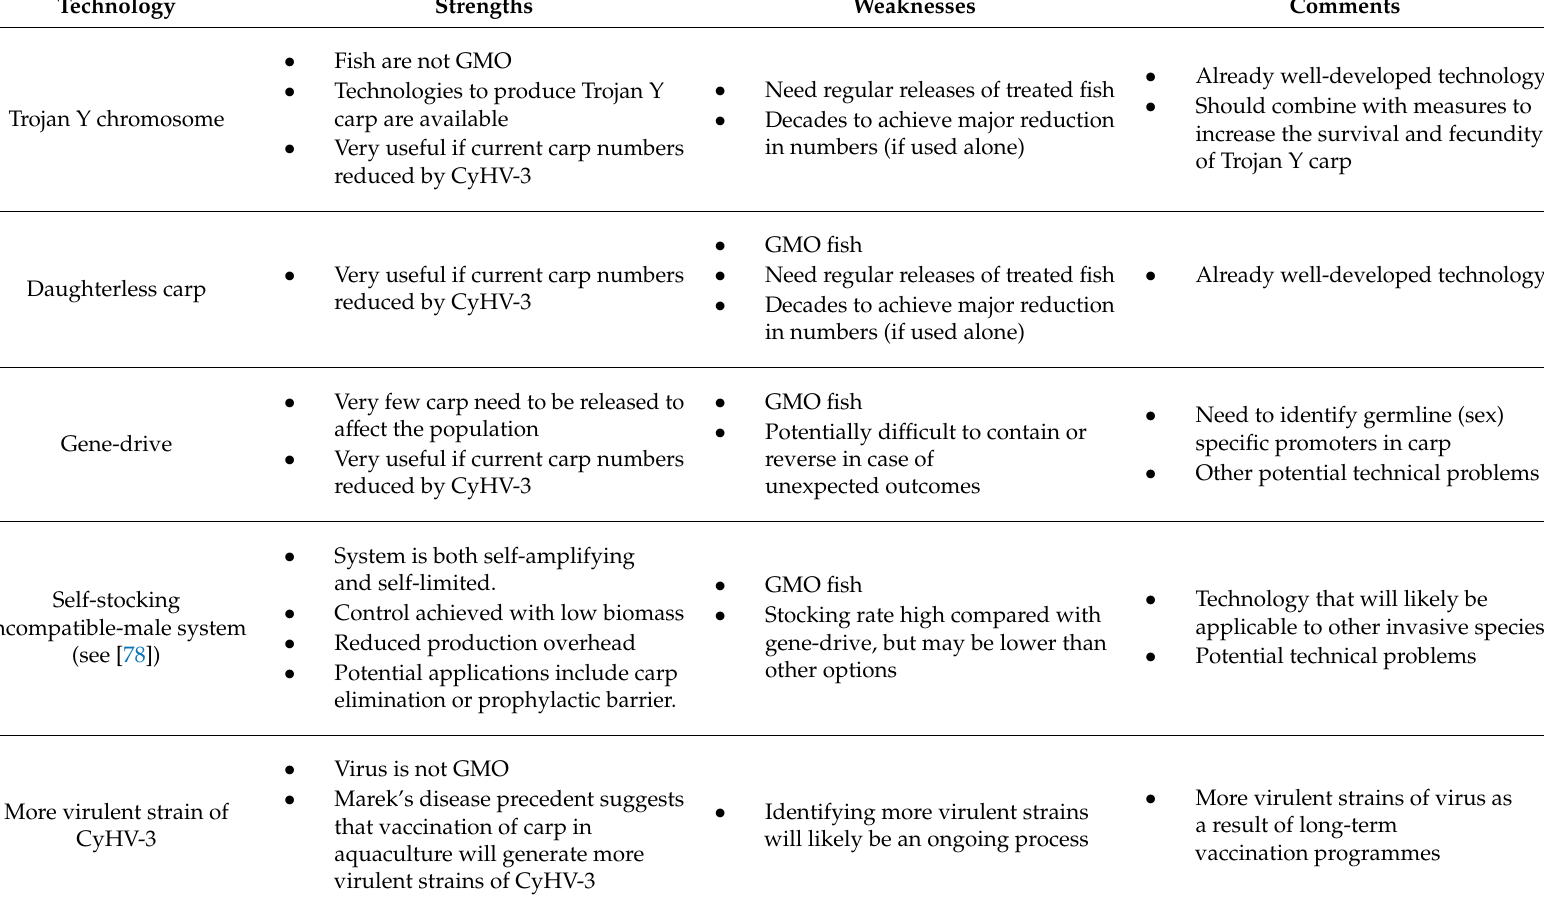
Table 2. Broad-scale control options to complement CyHV-3 biocontrol of carp in